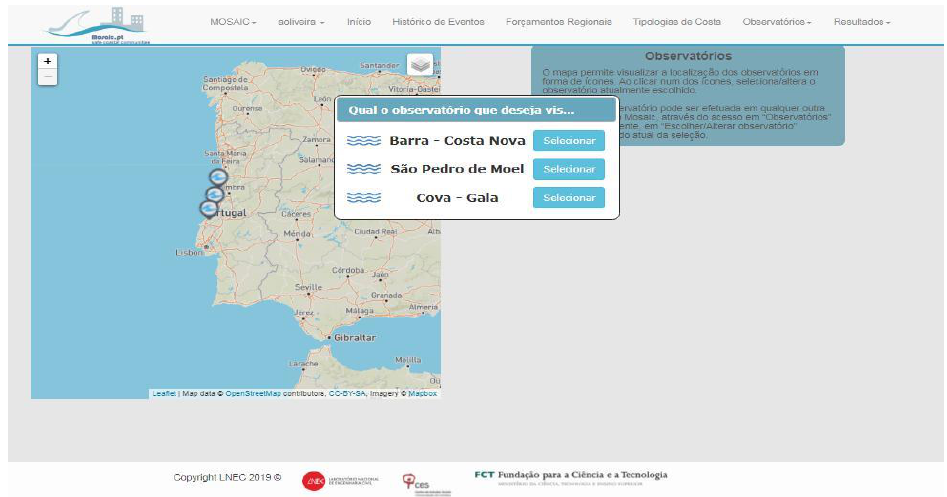
Figure 6. Observatory selection options: map (background) or list pop-up.